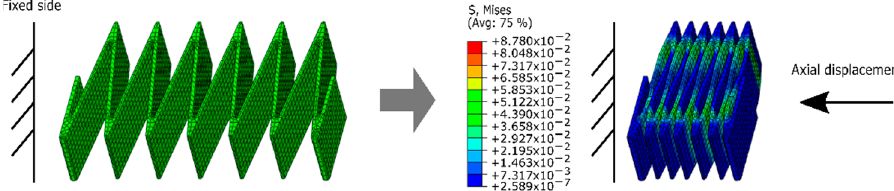
Figure 3. Schematic of the Finite Element Model setup of the skeleton, displaying stress concentrations for the uncontracted (constant zero-stress) and fully contracted states.